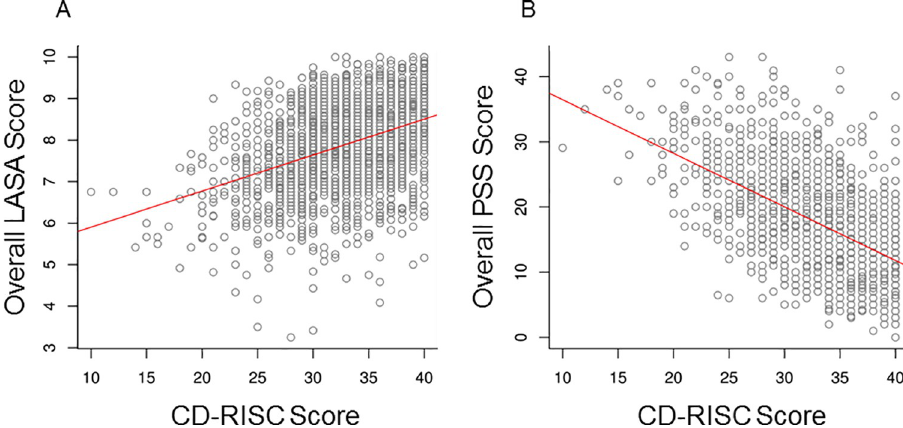
Fig 3. Scatterplots of association of LASA or PSS score With CD-RISC score. The estimated linear regression line is shown in red. A, Overall LASA score (correlation between LASA and CD-RISC = 0.40). B, PSS Score (correlation between PSS and CD-RISC = − 0.55). CD-RISC indicates Connor-Davidson Resilience Scale; LASA, Linear Analogue Self-Assessment; PSS, Perceived Stress Scale.